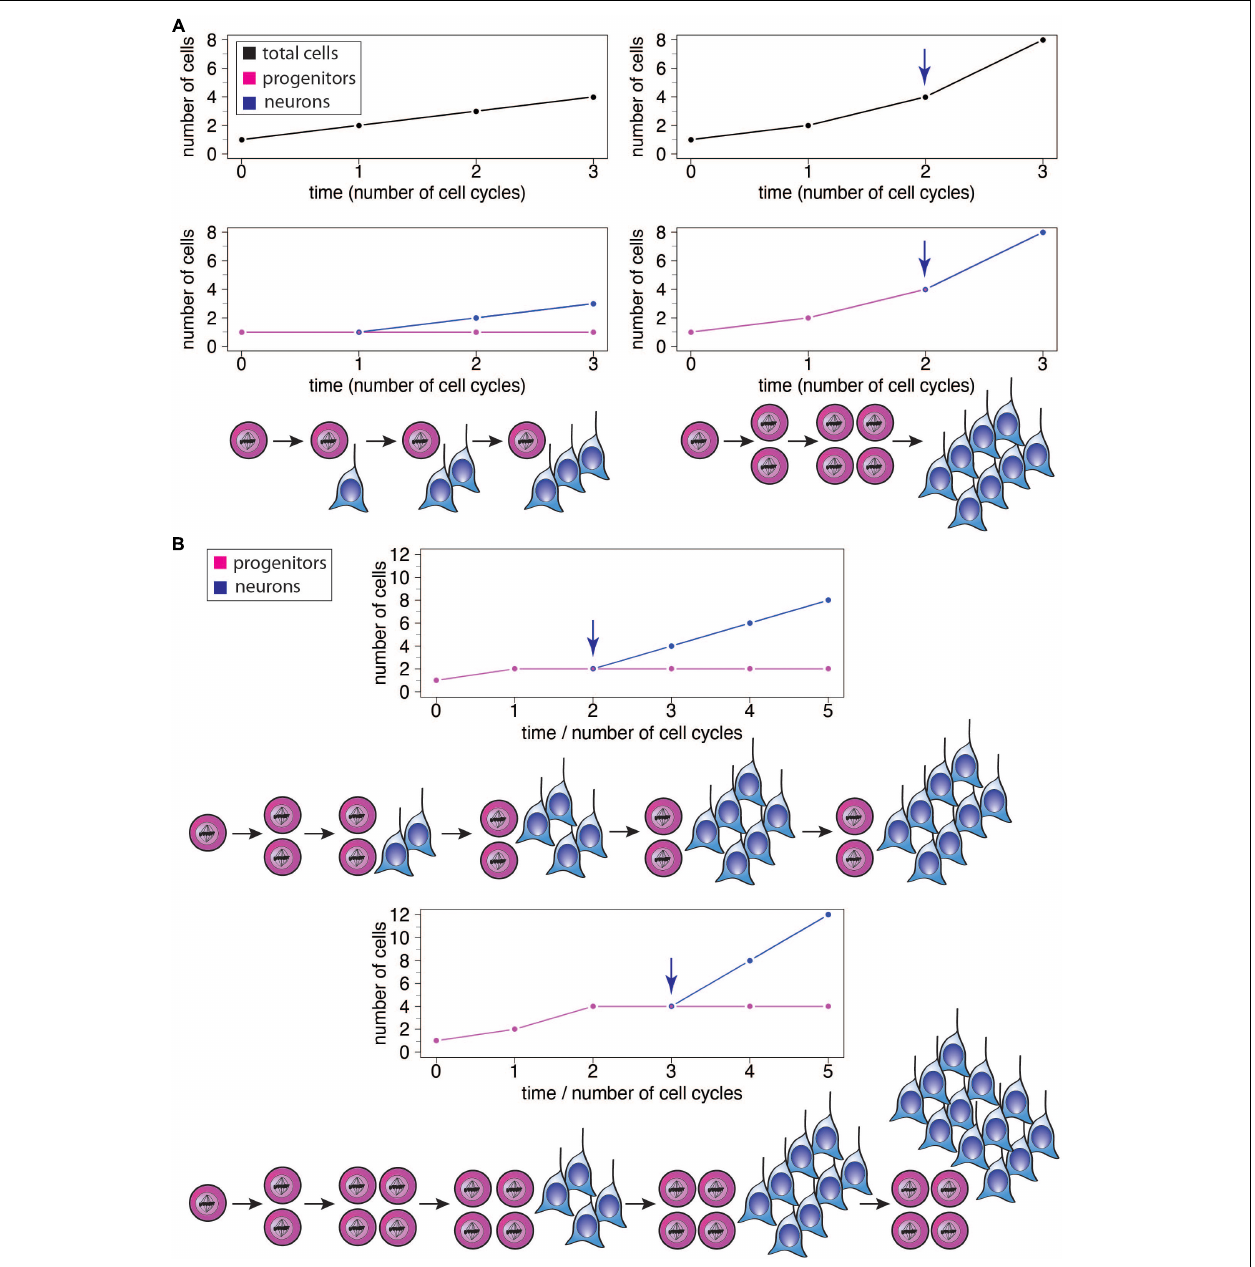
FIGURE 2 | (A) Illustration of the effects of different modes of progenitor division on the number of neurons produced, showing the results after 3 cell cycles each. Left: Asymmetric neurogenic progenitor divisions (1 progenitor: > 1 progenitor + 1 neuron; see diagram) lead to a linear increase in total cell number with every cell cycle (top graph, black), with the number of progenitors remaining constant (bottom graph, magenta) and the number of neurons increasing linearly after the first cell cycle (bottom graph, blue). Right: In contrast, symmetric divisions lead to an exponential increase in total cell number with every cell cycle (top graph). The initial symmetric proliferative progenitor divisions (1 progenitor: > 2 progenitors; see diagram) double the number of progenitors with every cell cycle (bottom graph, magenta). Upon progenitors switching to symmetric consumptive neurogenic division (arrow), the number of neurons (bottom graph, blue) is twice that of the (now consumed) progenitors. The longer the neurogenic period and the greater the number of progenitor cell cycles, the greater the increase in the number of neurons generated in the right scenario compared to the left one. (B) Illustration of the effects of delaying the switch of symmetric proliferative progenitor divisions to asymmetric neurogenic progenitor divisions (see top and bottom diagrams). Progenitors undergo one (top) or two (bottom) cycle(s) of symmetric proliferative division and then switch to asymmetric neurogenic progenitor divisions, with the number of progenitors then generated remaining constant and the number of neurons increasing linearly. The number of neurons produced upon each asymmetric neurogenic progenitor division matches the number of progenitors present. Because the number of progenitors is twice as high after two (bottom) than one (top) cycle(s) of symmetric proliferative division, the number of neurons added upon each cycle of asymmetric neurogenic progenitor division is twice as high in the bottom than top scenario, leading to a steeper increase in neuron numbers and a greater neuron output in the bottom scenario, although neurogenesis starts one progenitor cycle later.